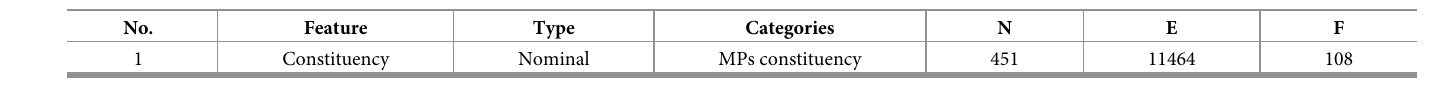
Symbols N, E, and F show the number of nodes, the number of edges, and the number of node features,